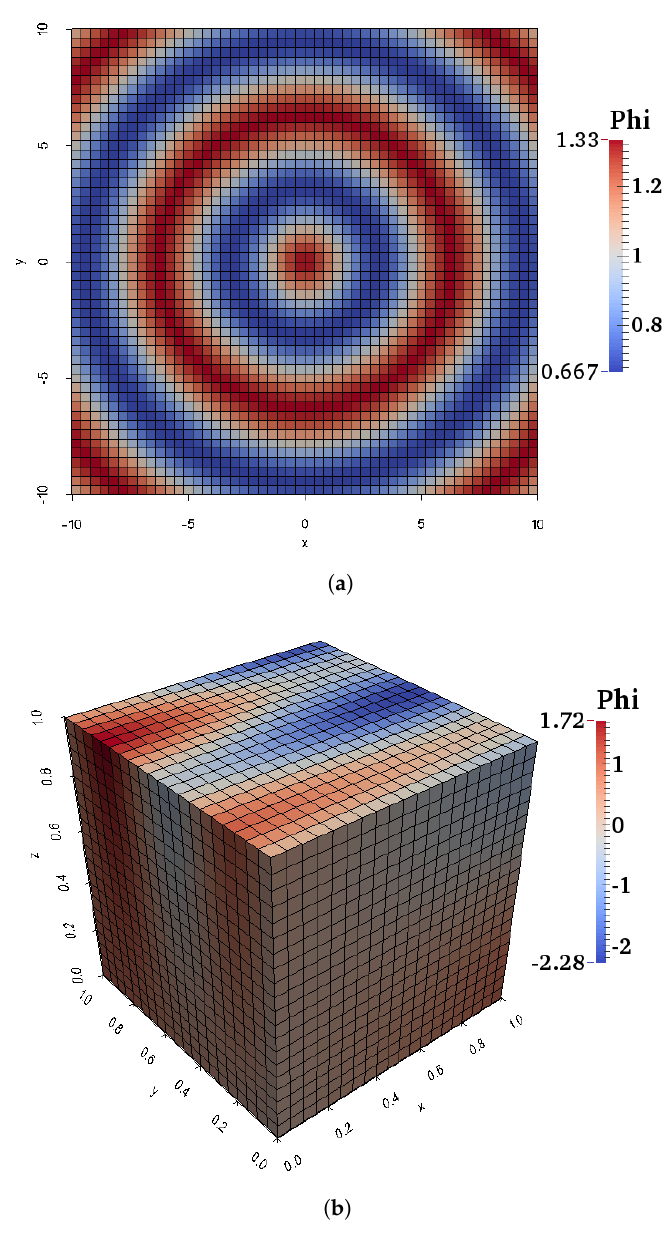
Figure 7. Initial data for the reconstruction of the smooth functions. ( a ) 2D function; ( b ) 3D function. Table 1. Order of accuracy from the numerical convergence study for the smooth, two-dimensional function on hexahedral α hex and triangular α t grids using L 2